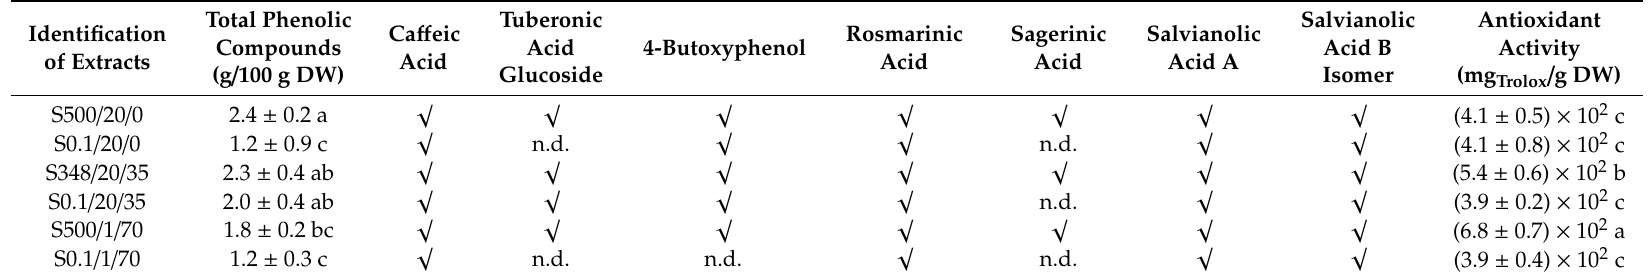
Table 2. Phenolic compounds identified in winter savory leaves extracts by LC-MS / MS, and antioxidant activity obtained by ORAC assay. Di ff erent letters indicate significant di ff erences ( p < 0.05) between extracts for each condition set (di ff erences analyzed by